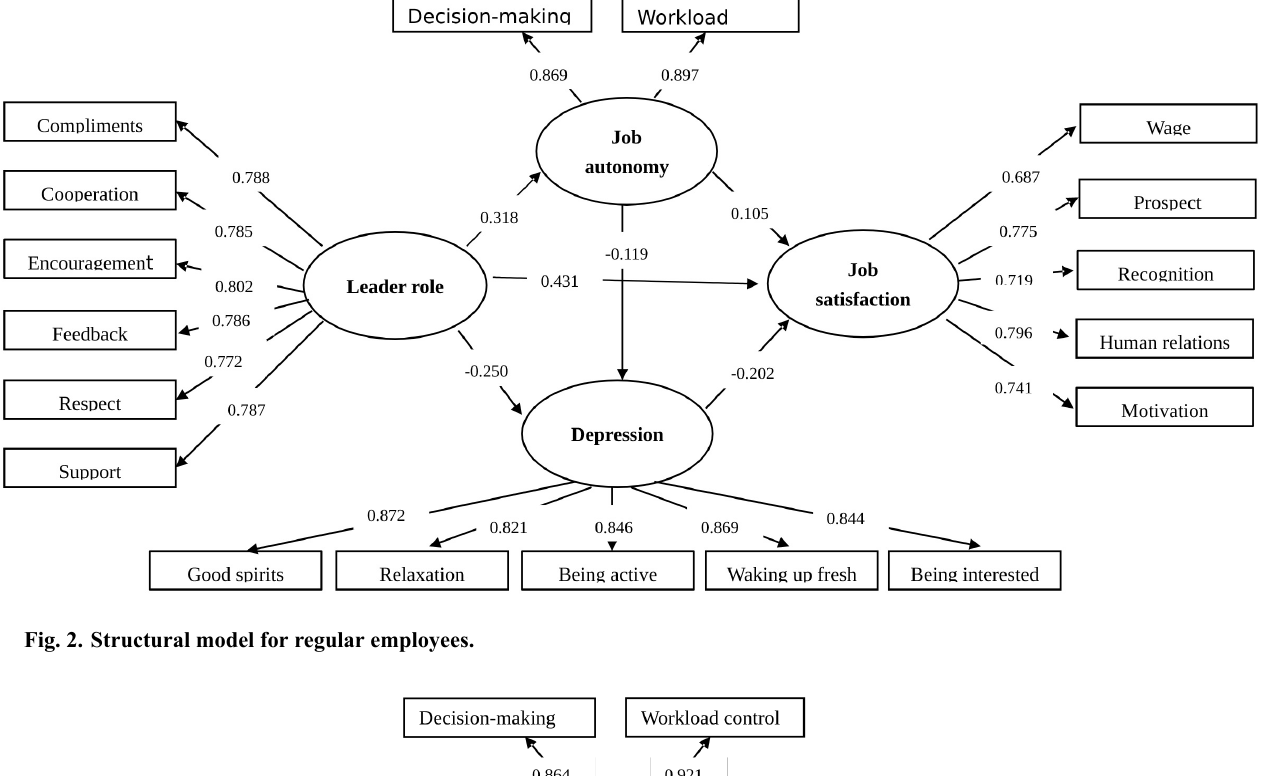
Fig. 2. Structural model for regular employees.